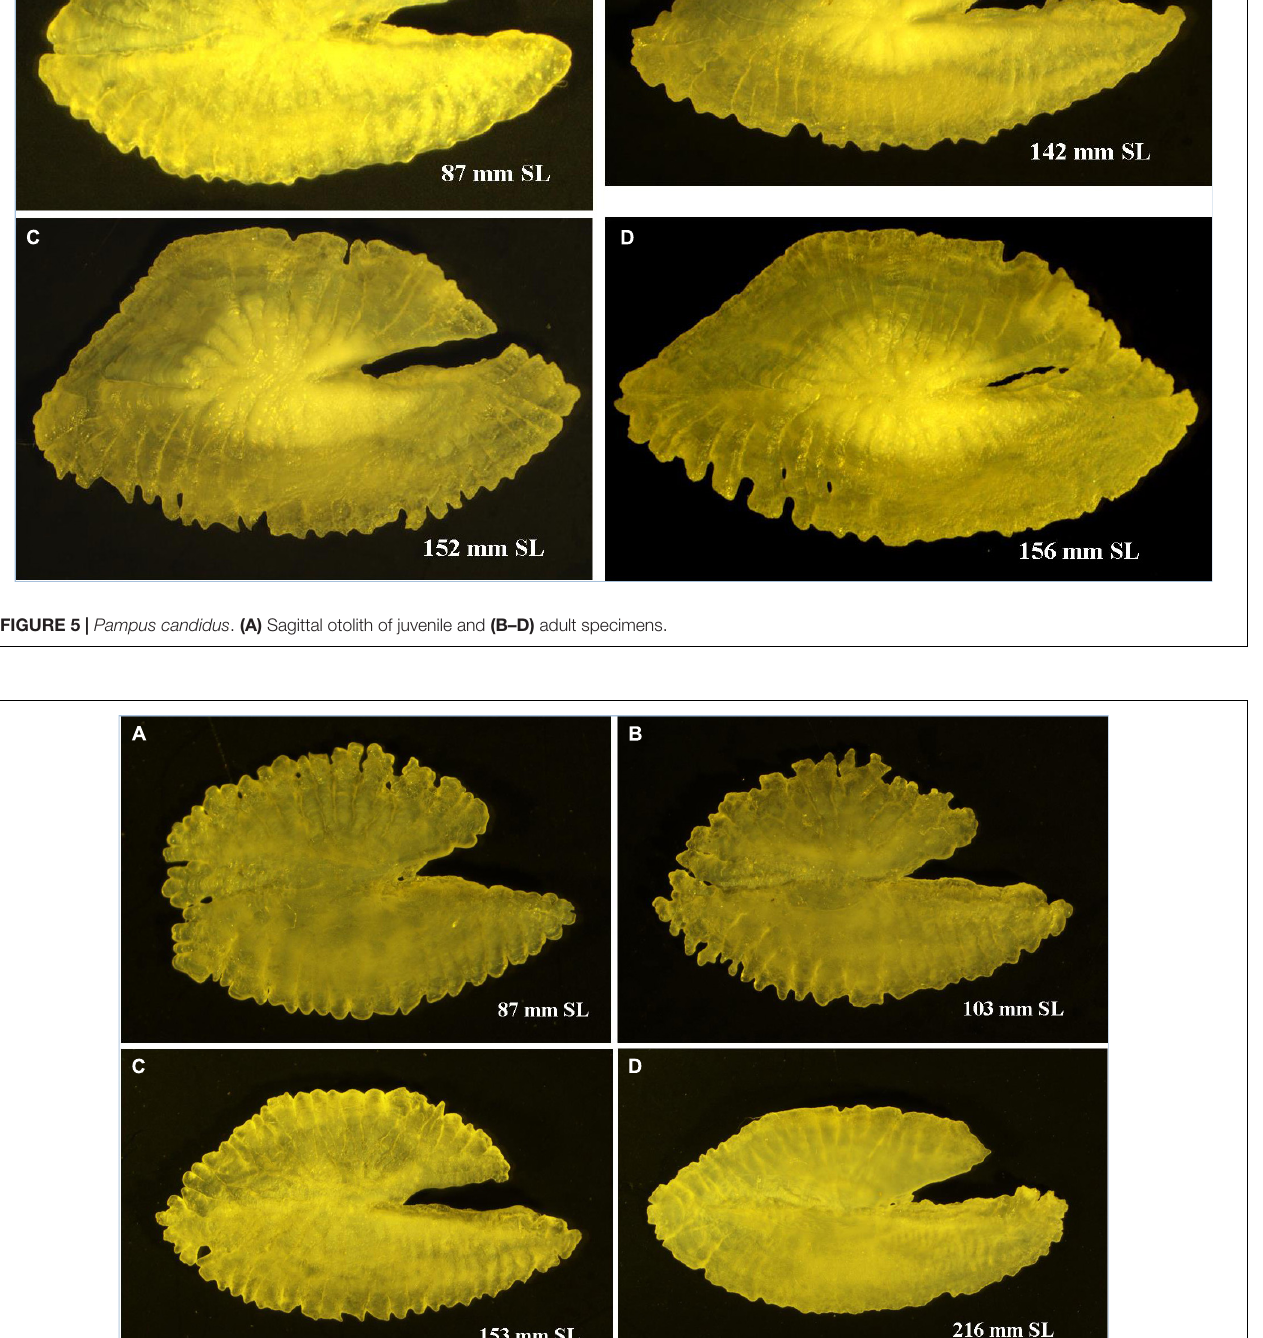
Frontiers in Marine Science |